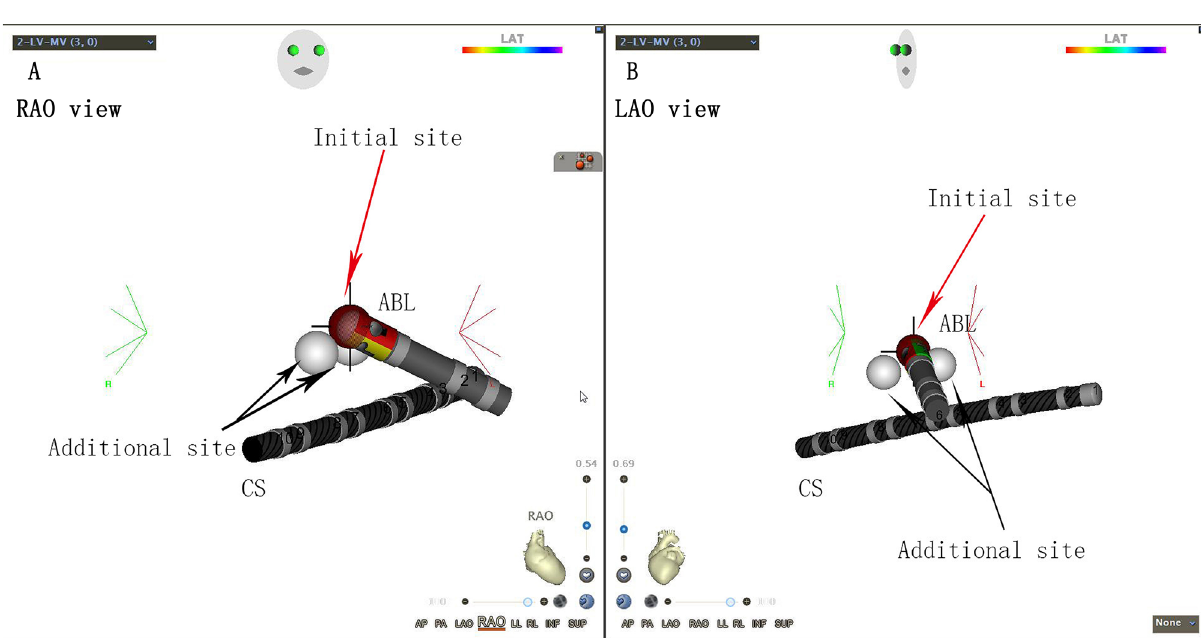
Figure 2. 3D electroanatomic mapping (CARTO3 V4.3.5.68; Biosense Webster, Irvine, CA, USA) for Ap ablation. The red point refers to the initial ablation site, and the white point shows the additional site. CS coronary sinus, ABL ablation